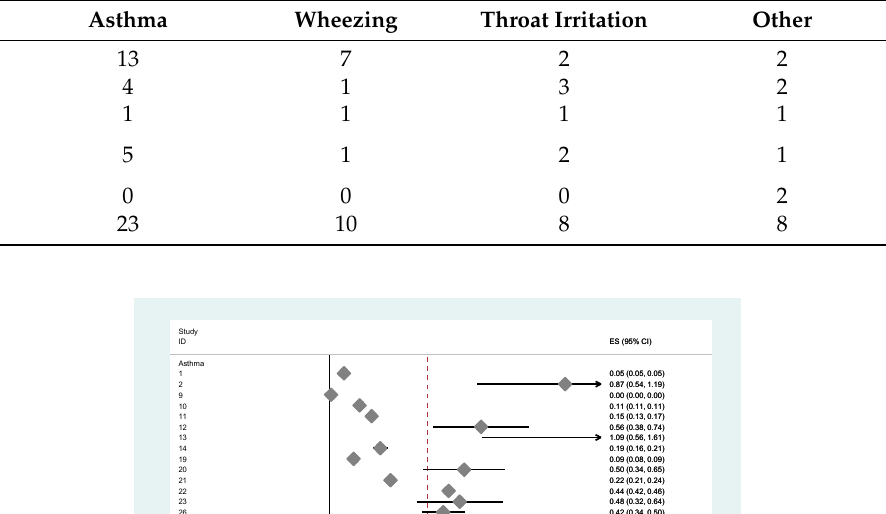
asthma (23/49), wheezing (10/49), throat irritation (8/49) and others (8/49). About half of these studies focused on the pediatric population and the remaining studies included all age groups or the 18+ population, as summarized in Table 1. The study specific effect sizes of the association of VOCs and selected diseases or symptoms are presented in Figure 1. The average effects size, irrespective of air pollution and health outcome types, across 49 studies was 0.37, a medium effect size (95% confidence interval (CI) = 0.29–0.44). This effect size varied across countries (Table 3). The highest effects of VOCs on any of the four outcomes was observed in Iran, followed by Korea, Germany, Sweden, The Netherlands and France. The lowest effect of VOCs was observed in Argentina, followed by Australia, South Africa and Canada. The effect size in the US was 0.36, which is close to the average effect size of all studies. Table 1. Sample age by reported health outcomes of the studies included in the meta-analysis.